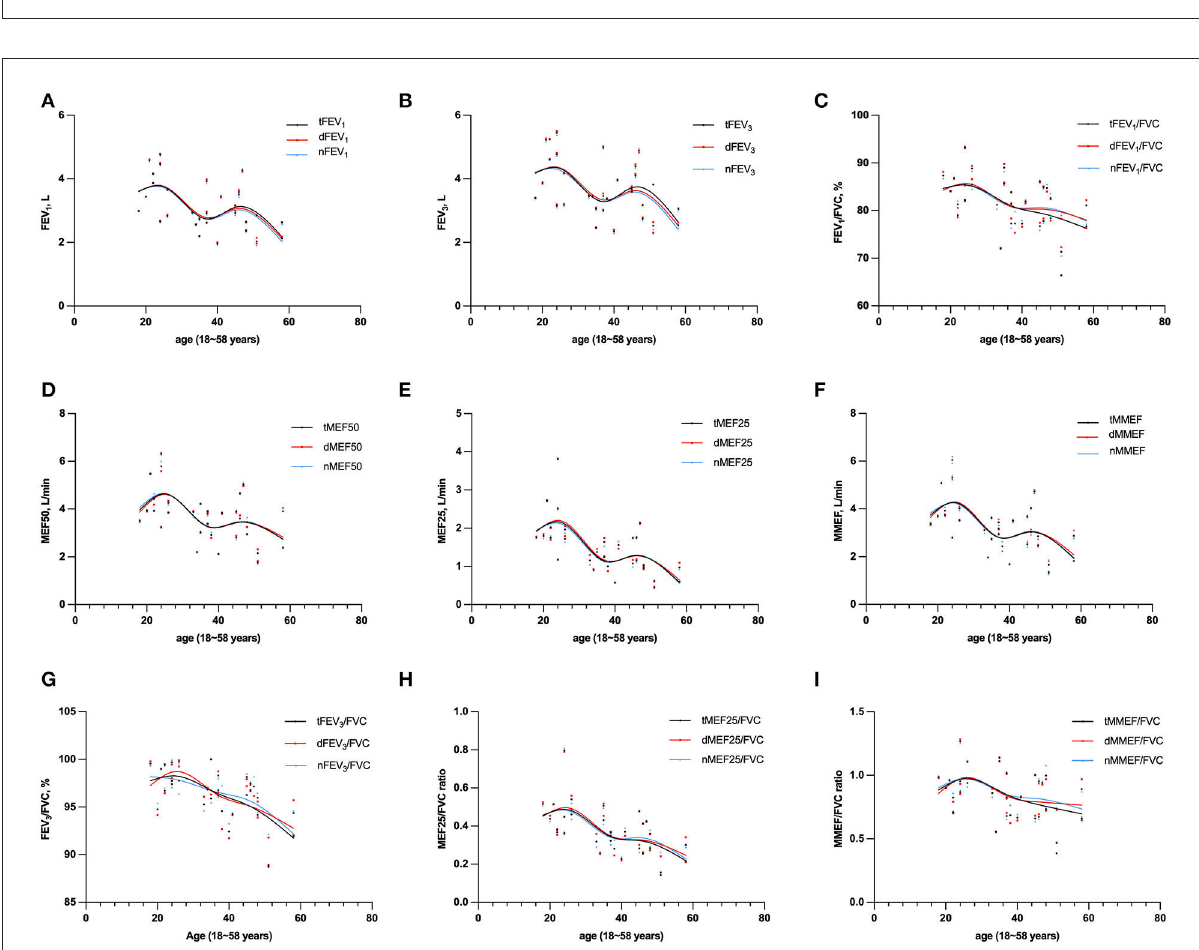
FIGURE3 Absolute values for FEV 1 (A) , FEV 3 (B) , MEF50 (D) , MEF25 (E) , and MMEF (F) , ratio values for FEV 1 /FVC (C) , FEV 3 /FVC (G) , MEF25/FVC (H) , and MMEF/FVC (I) by age ( N = 31, except N = 30 for PEF). Graphs were generated to illustrate characteristics of large- and small airway function values by age. FVC, forced vital capacity; FEV 1 , forced expiratory volume in 1s; FEV 3 , FEV in 3s; MEF50: forced expiratory flow at 50% of forced vital capacity; MEF25: forced expiratory flow at 75% of forced vital capacity; MMEF: forced expiratory flow between 25 and 75%; PEF, peak expiratory flow; SD, standard deviation; CI, confidence interval; t-, total; m-, morning; e-, evening.